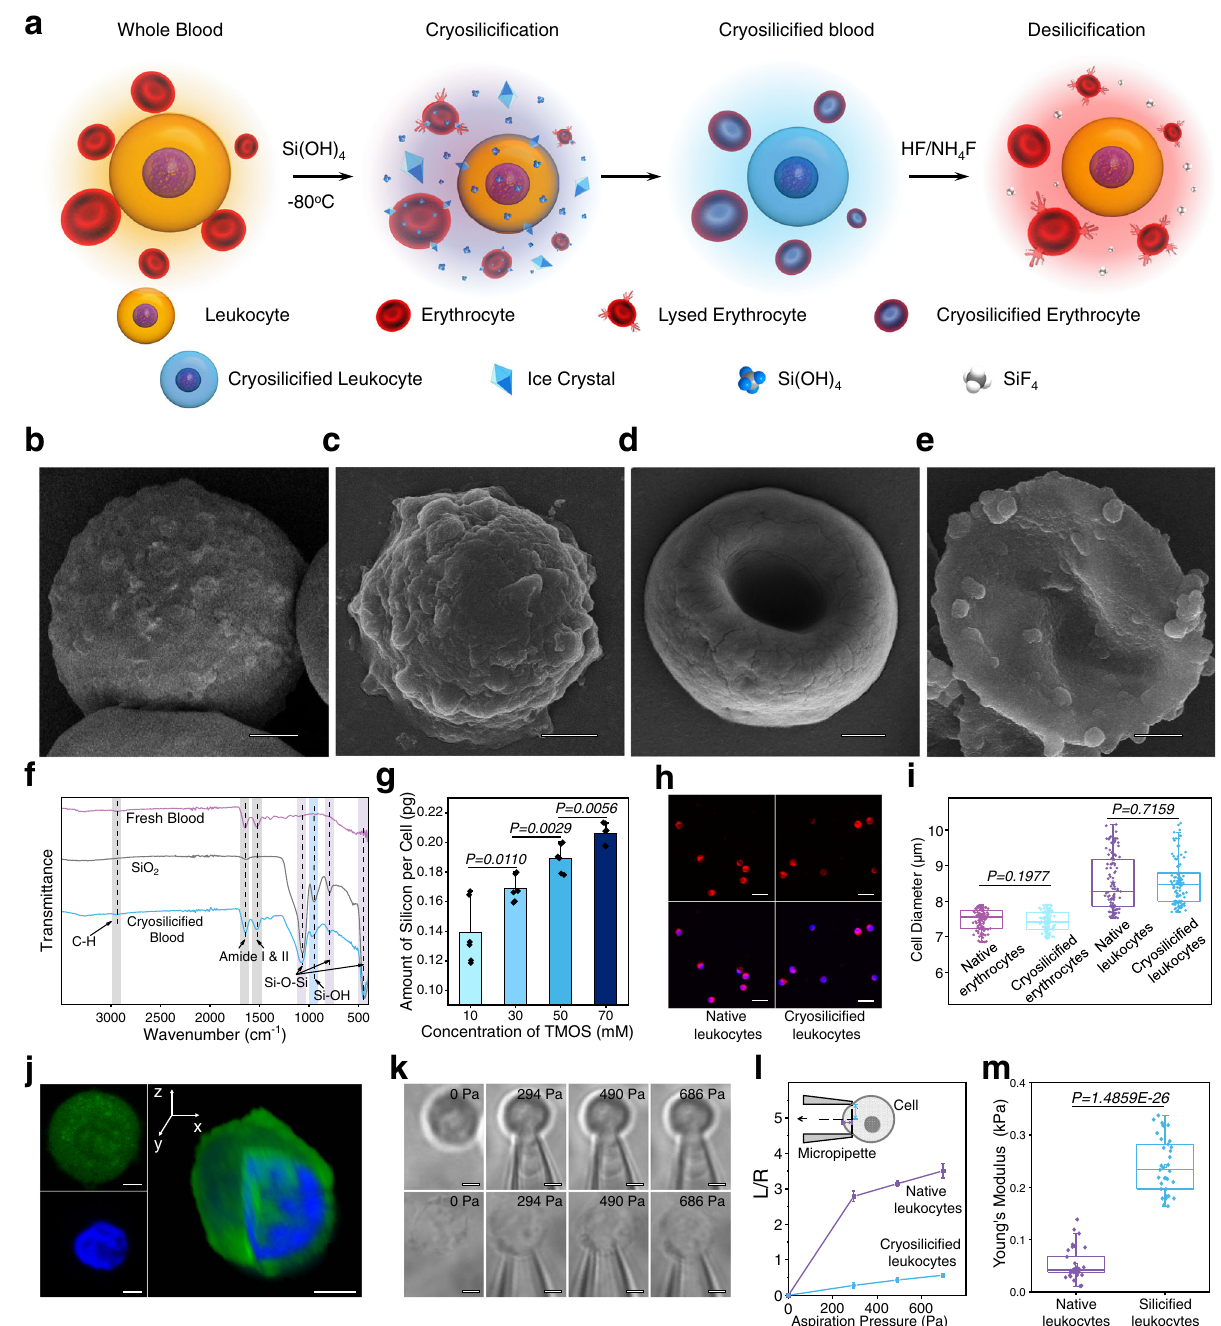
Fig. 2 |Insitucryosilici fi cationofwhole-bloodcells. a Schematicrepresentation of the procedure of cell cryosilici fi cation and desilici fi cation. b – e SEM images of b native leukocyte, c cryosilici fi ed leukocyte, d native erythrocyte, and e cryosilici fi ed erythrocyte, Scale bars=1 μ m. A representative image of three biological replicates is shown. f FTIR spectroscopy of native blood (purple), silica (gray),andcryosilici fi edblood(blue).Arepresentativespectrumofthreebiological replicatesisshown. g Siliconcontentofcryosilici fi edbloodpreparedwithdifferent silicaprecursorsconcentrationdeterminedbyICP-OES.Sixbiologicalreplicatesare shown. h Fluorescent microscopy images of native and cryosilici fi ed leukocytes. Cell nucleus was stained by Hoechst 33342 (blue), and the cell membrane was stainedbyDiD(red),Scalebars=20 μ m.Arepresentativeimageofthreebiological replicates is shown. i Cell diameter of leukocyte and erythrocyte after cryosilici fi - cation. Box and whiskers represent mean±25 – 75 percentile, center values 7.393,